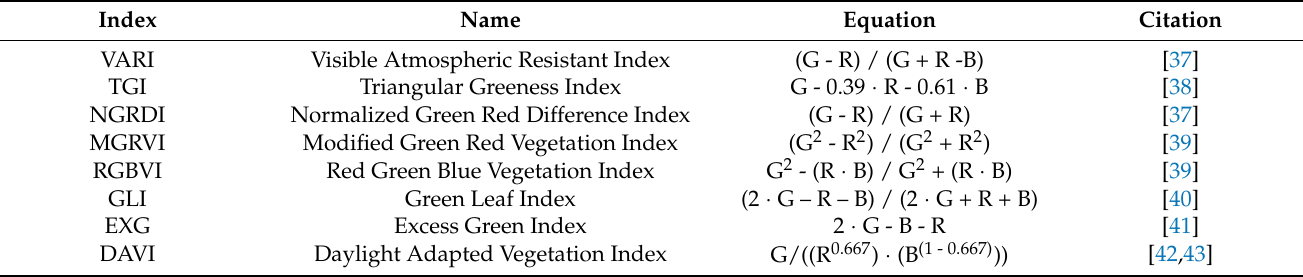
Table 2. Spectral indices calculated as additional layers from the before-mowing images; RGB = red-green-blue channels for 8-bit image digital numbers (grey-values).